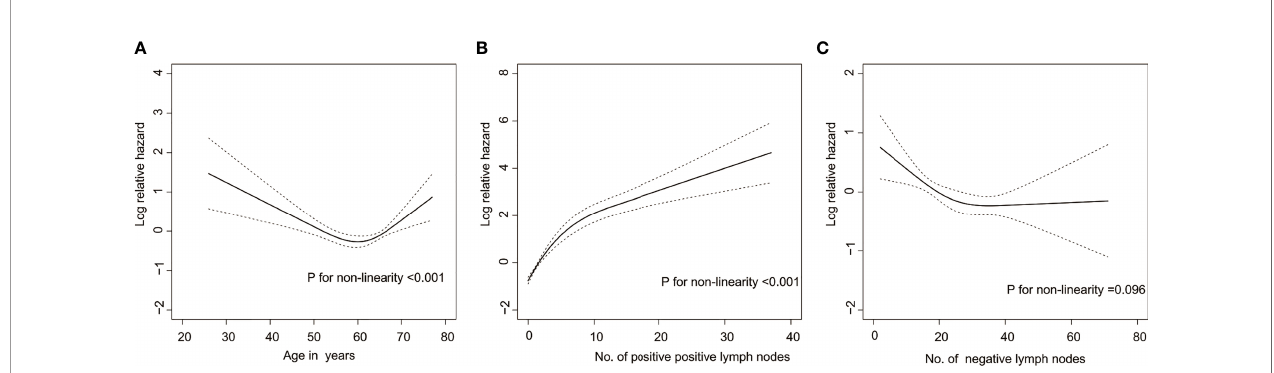
FIGURE 1 | Risk of recurrence as a function of (A) age, (B) Number of positive lymph nodes, and (C) Number of negative lymph nodes. Solid line = risk function. Dashed lines = 95% con fi dence bands for the risk function.